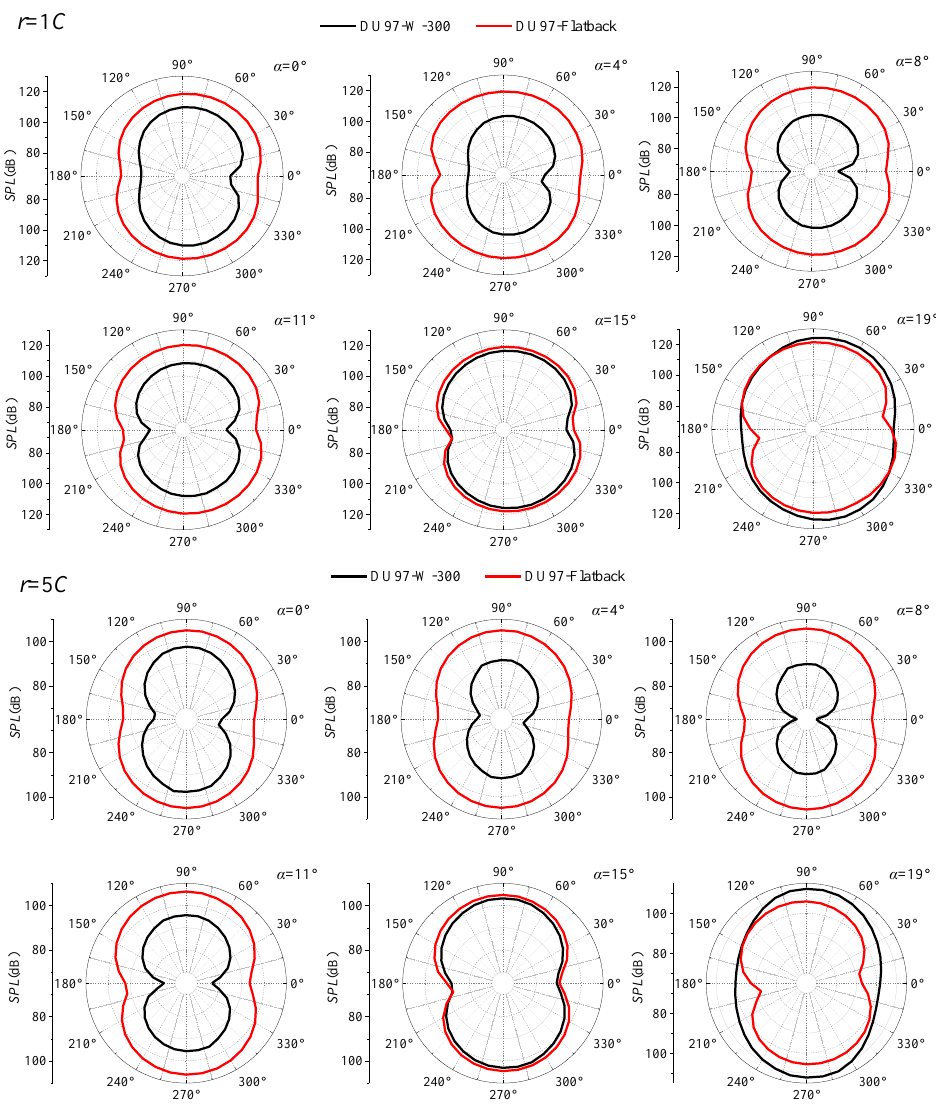
Figure 15. The directional distribution curves of SPL.